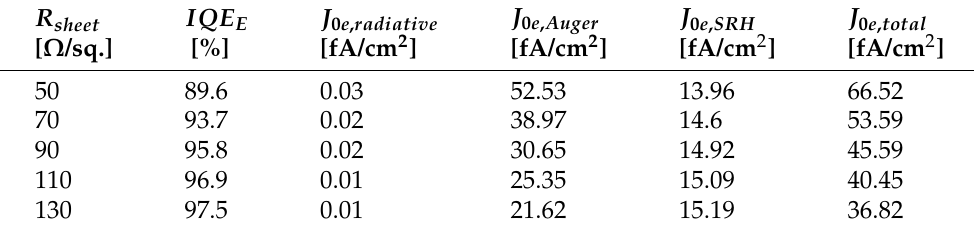
Table 2. Impact of variation in the emitter saturation current densities as a function of R sheet .